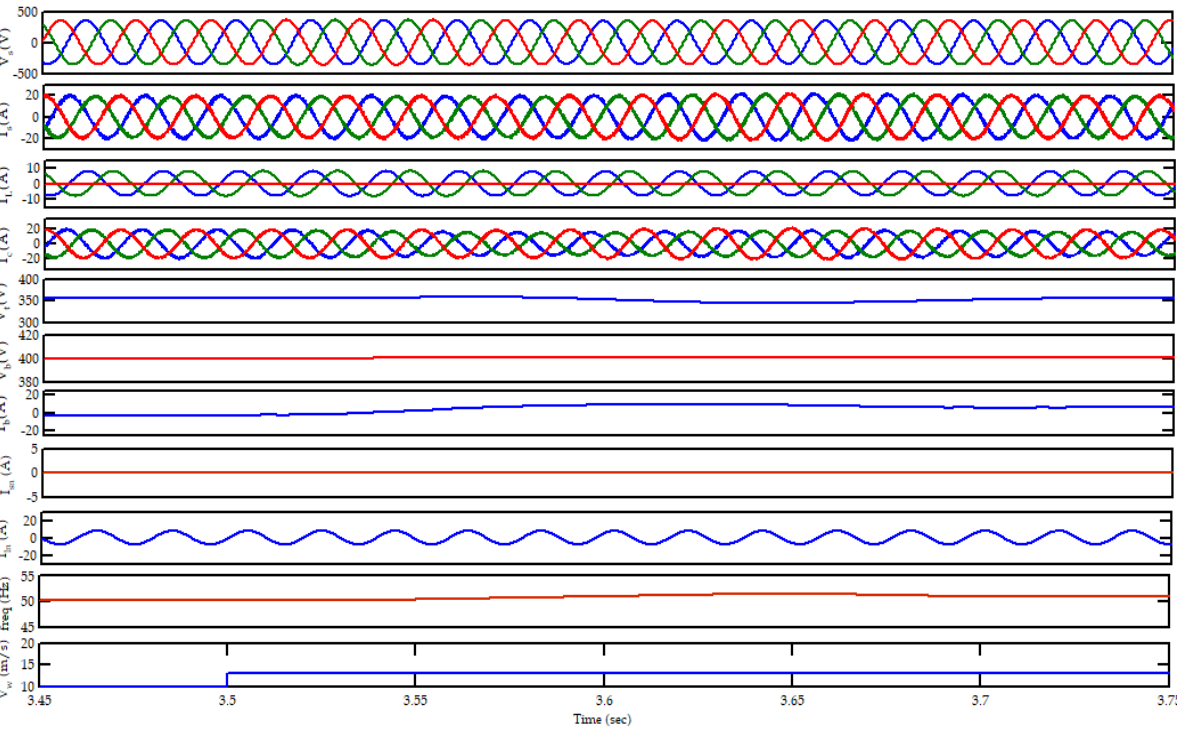
Figure 10. Performance of the Wind power unit with nonlinear load when the wind speed changes from 11 m/s to 13 m/s.